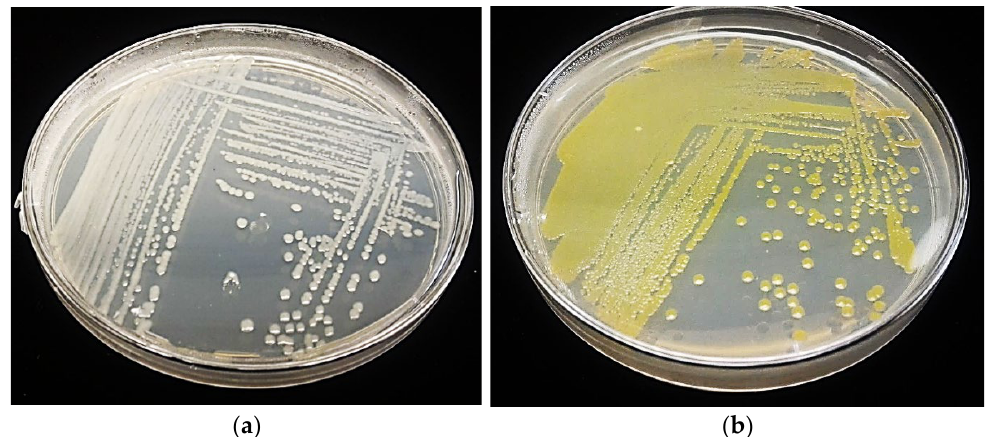
Figure 5. ( a ) Creamy and ( b ) yellowish colony morphology of P. stewartii subsp. stewartii on a King’s B agar medium isolated from jackfruit ( A. heterophyllus) samples suffering from a bronzing disease in Malaysia (Figures were from personal collection).